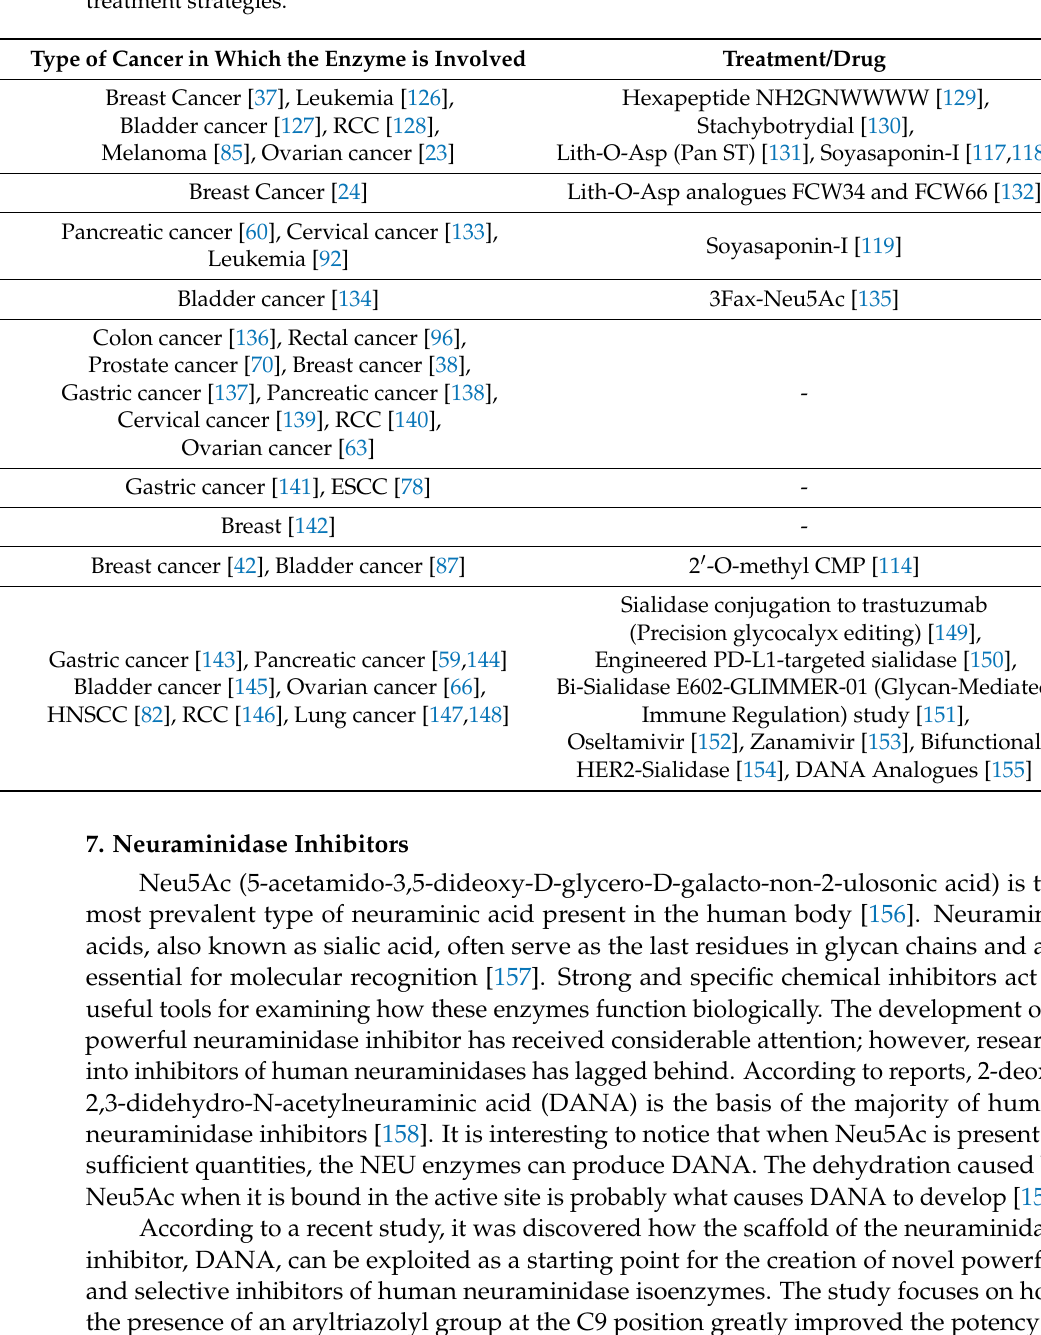
Table 3. Important enzymes involved in sialylation, their role in different cancers, and respective treatment